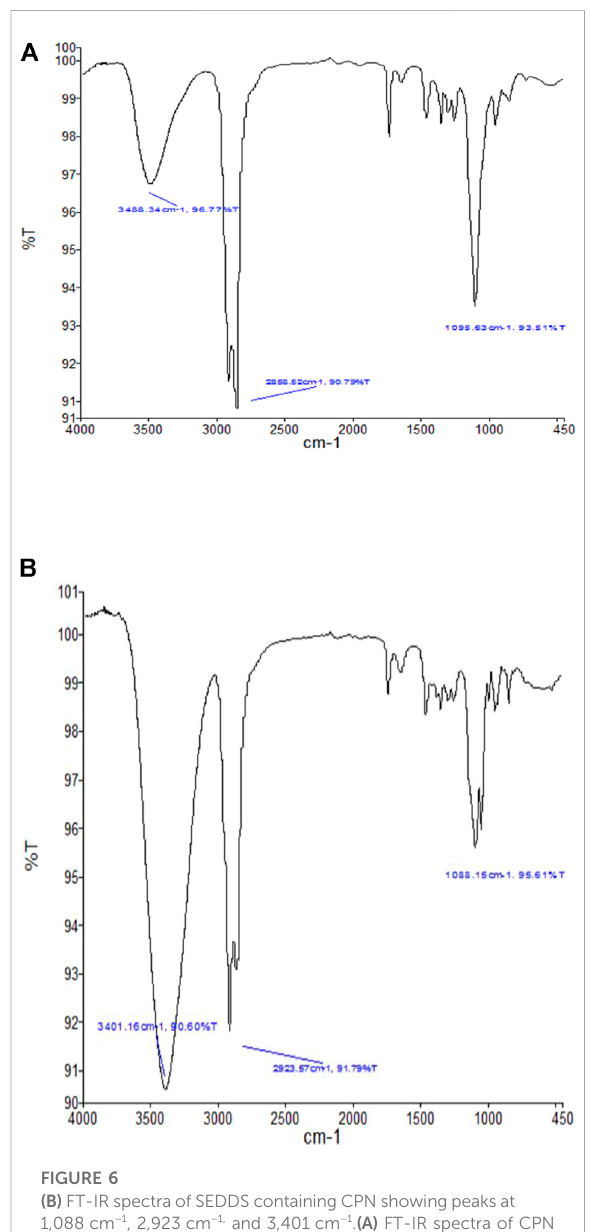
FIGURE 6 (B) FT-IR spectra of SEDDS containing CPN showing peaks at 1,088 cm − 1 , 2,923 cm − 1, and 3,401 cm − 1 . (A) FT-IR spectra of CPN showing characteristic peaks at 1,095 cm − 1 , 2,858 cm − 1 , and 3,488 cm − 1